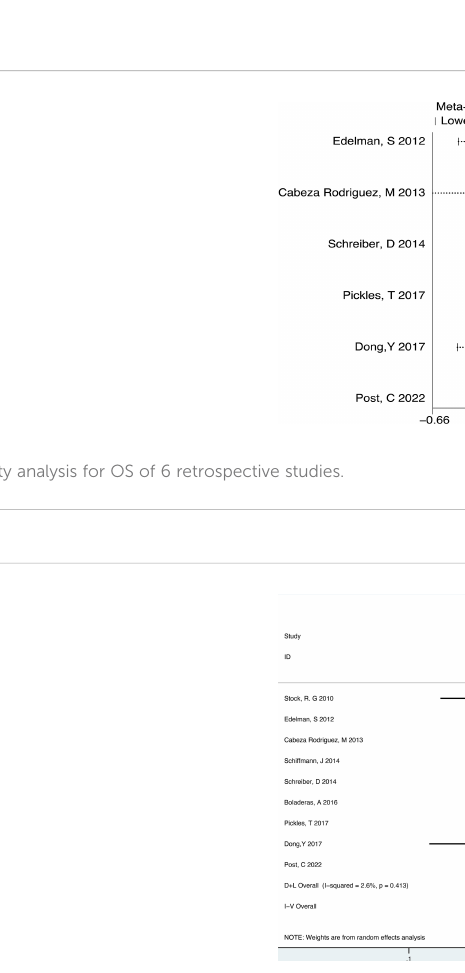
FIGURE 7 Forest plot for BCRFS of 9 retrospective studies.